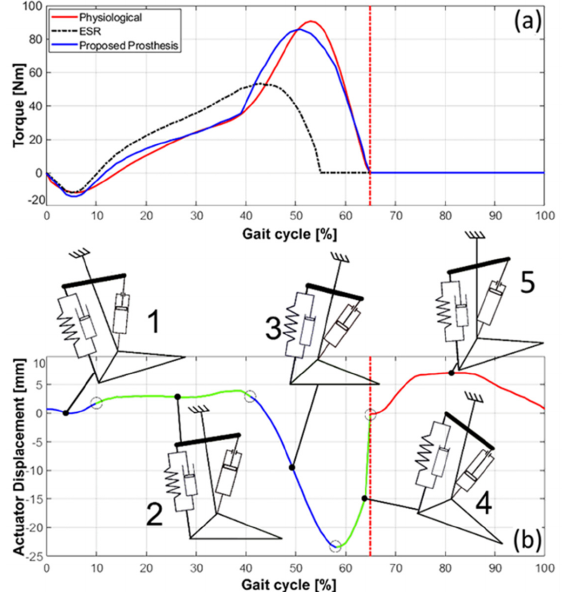
Figure 4. ( a ) The diagram of the ankle torque for 3 different gait conditions: the physiological gait, the one with the ESR foot and the one with the modeling based on the proposed prosthesis and, ( b ), the diagram of the actuator displacement and configuration of the ankle-foot prosthesis: 1 is the heel strike sub-phase; 2 is the foot-flat sub-phase; 3 is the start of the pre-swing phase; 4 is the ending of the pre-swing sub-phase when the foot detaches from the ground; 5 is the swing phase.